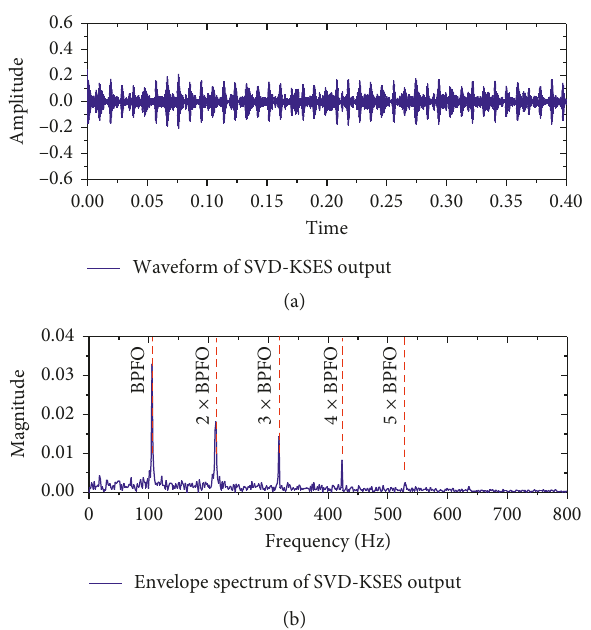
Figure 7: Output of SVD-AKTEO. (a) The waveform of SVD- AKTEO output. (b) The TEO spectrum of the signal in (a).